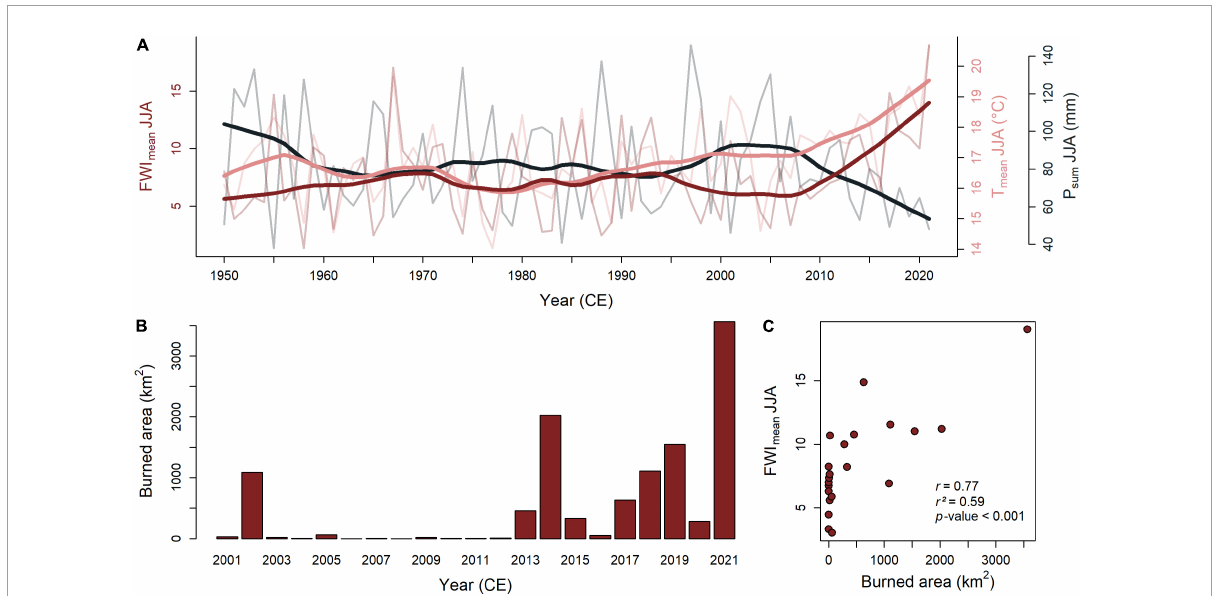
FIGURE2 (A) ERA5 reanalysis data at Lake Satagay (Hersbach et al., 2020) for temperature, precipitation, and a fire-weather-index (FWI; calculated from daily values with the R package “cffdrs”; Wang et al., 2017) from 1950 to 2020 CE. (B) Burnt area in a 200 km buffer around Lake Satagay